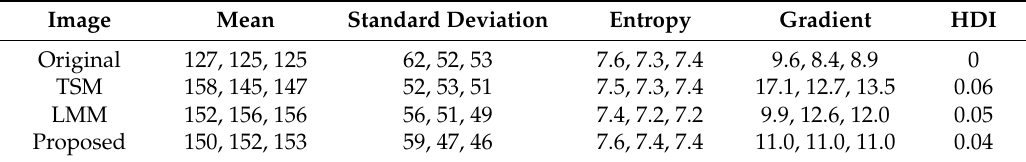
Table 4. Quantitative analysis of the methods in test